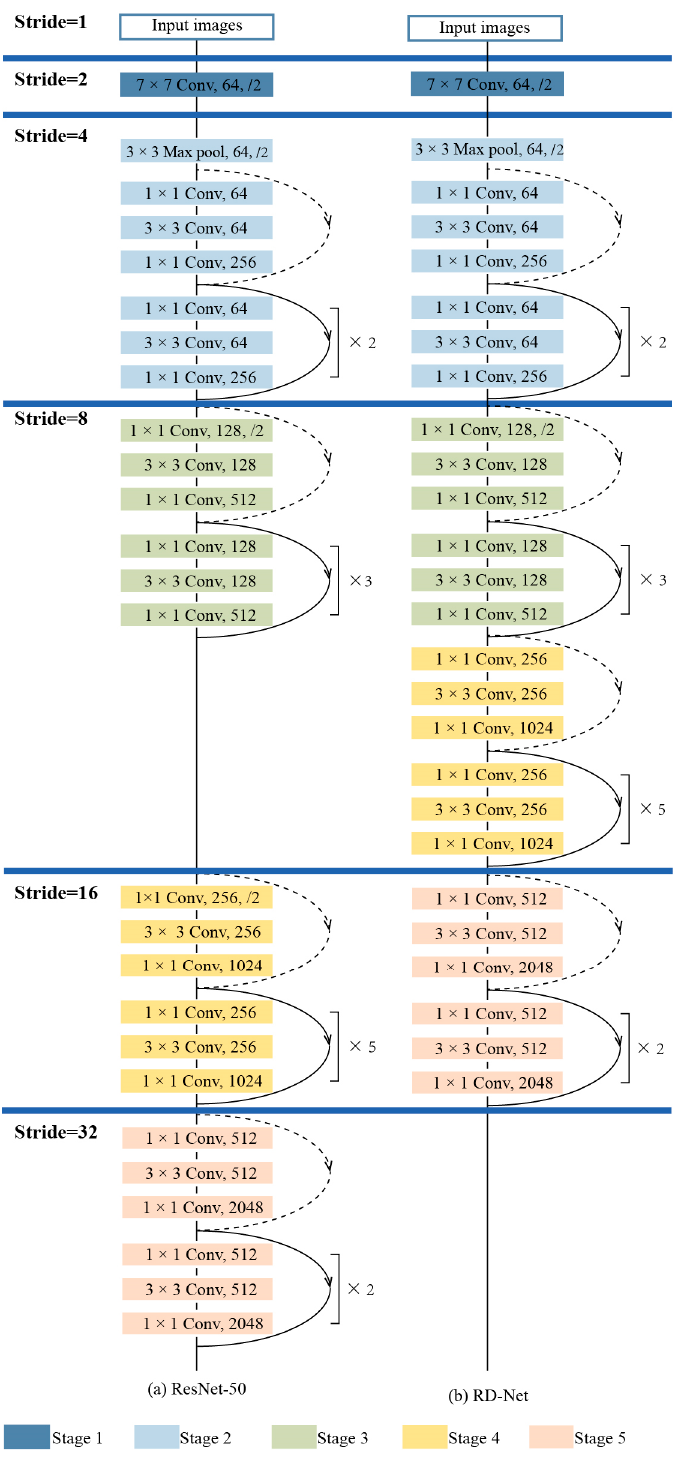
Figure 2. Network structure of ResNet-50 and RD-Net. Solid line with arrow presents projection shortcut and dash line with arrow presents identity shortcut.